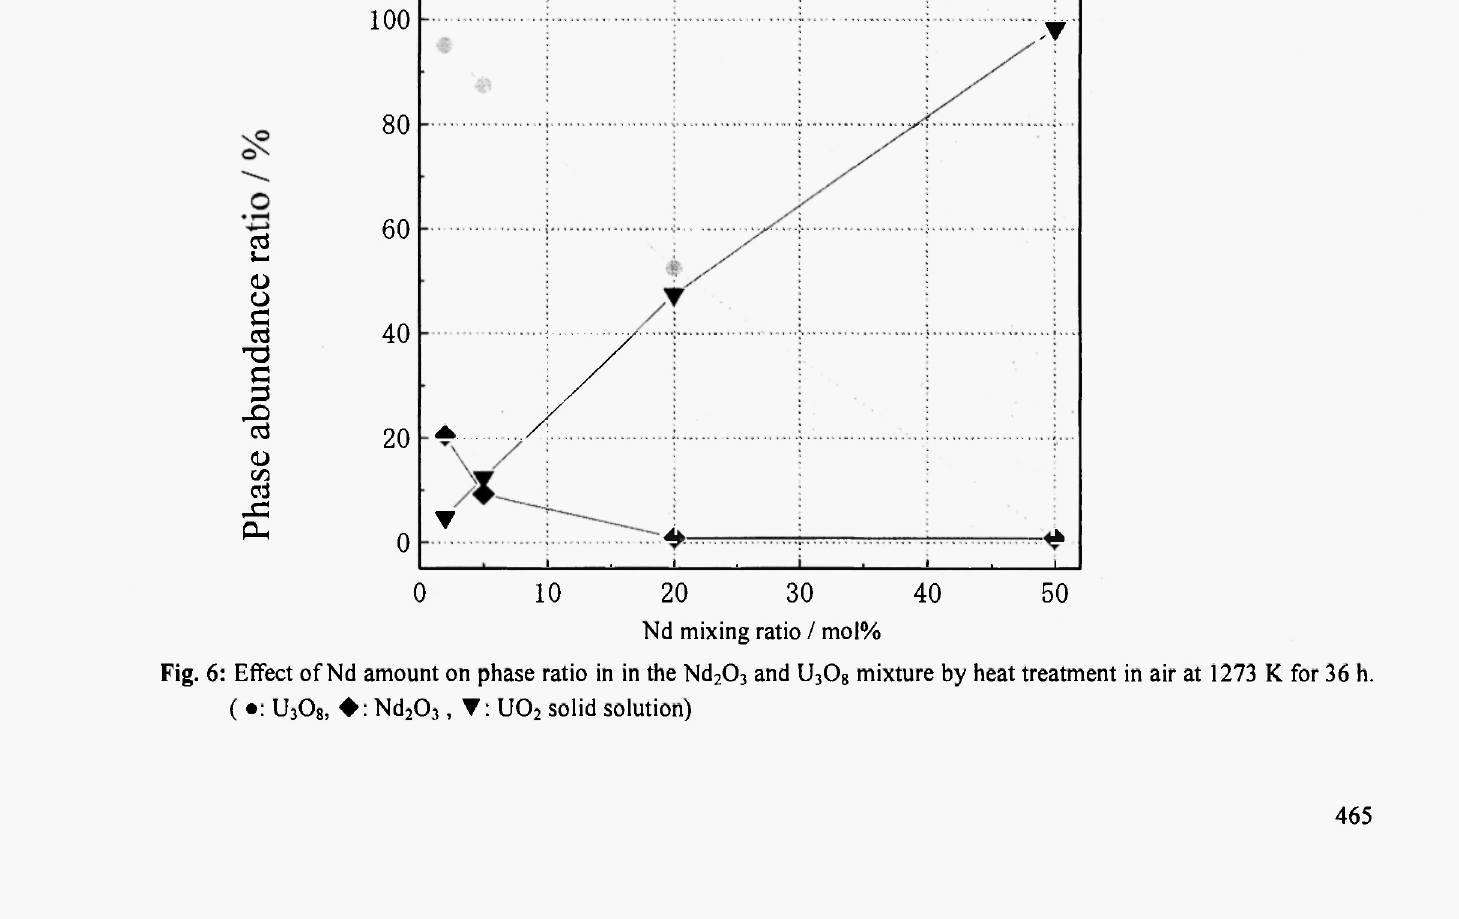
Fig. 6: Effect of Nd amount on phase ratio in in the Nd 2 0 3 and U 3 O s mixture by heat treatment in air at 1273 Κ for 36 h. ( ·: U 3 0 8 , •: N d 2 0 3